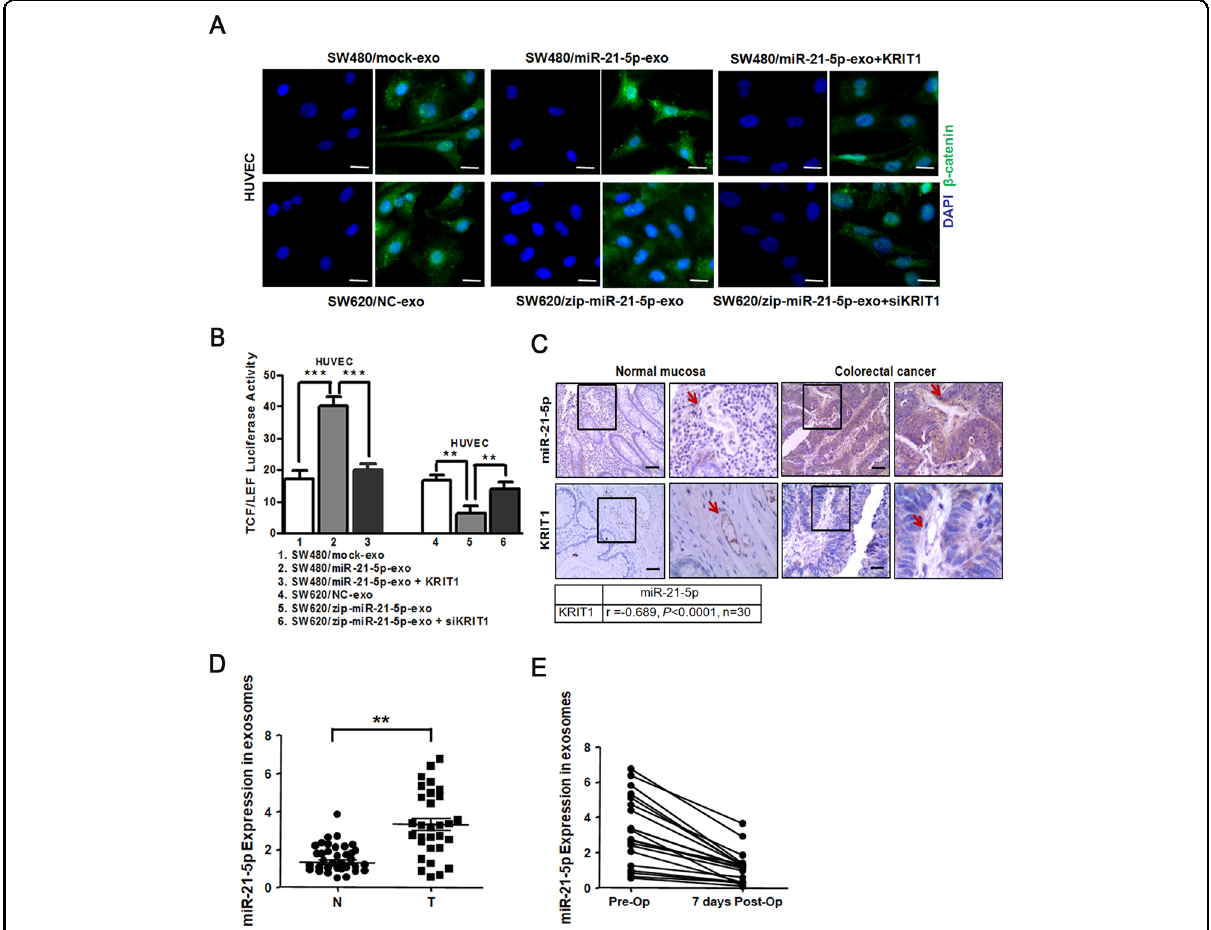
Fig. 5 Correlations of miR-21-5p with KRIT1 expression in CRC-adjacent vessels. A Immuno fl uorescence images of nuclear translocation of β -catenin in HUVECs treated with SW480/mock exosomes, SW480/miR-21-5p exosomes, SW480/miR-21-5p exosomes + KRIT1, SW620/NC exosomes, SW620/zip-miR-21-5p exosomes or SW620/zip-miR-21-5p exosomes + siKRIT1. Scale bars represent 5 µm. B Luciferase activities of TCF/LEF transcription in HUVECs treated with SW480/mock exosomes, SW480/miR-21-5p exosomes, SW480/miR-21-5p exosomes + KRIT1, SW620/NC exosomes, SW620/zip-miR-21-5p exosomes or SW620/zip-miR-21-5p exosomes + siKRIT1. Mean ± SEM are provided ( n = 3). C Correlation analysis between miR-21-5p and KRIT1 expression in vessels (indicated by arrows) adjacent to primary CRC tissues or matched normal mucosa. MiR-21-5p levels were scored by ISH, while KRIT1 levels were scored by IHC. Spearman ’ s correlation coef fi cient ( r ) and P -value are shown ( n = 30). Scale bars represent 50 µm. D Expression of miR-21-5p in exosomes derived from the serum of CRC patients (T) and healthy donors (N) (N = T = 30). E Expression of miR-21-5p in exosomes derived from the serum of CRC patients that received a radical operation on the day of operation (Pre-Op) and 7 days after the operation (7 days Post-Op) ( n = 20). * P < 0.05, ** P < 0.01, *** P <